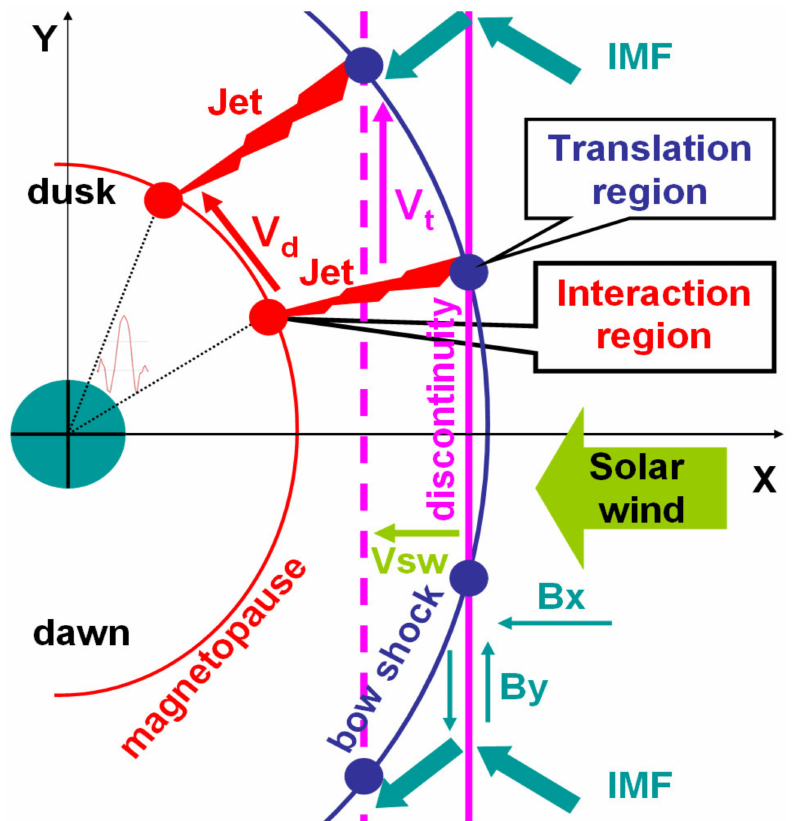
Figure 8. A sketch of the solar wind interaction with the magnetosphere during the generation of traveling jet in the magnetosheath. A discontinuity of the IMF By reversal from negative to positive propagates with the solar wind velocity Vsw from the noon sector (violet solid line) toward flanks (violet dashed line). Interaction of the discontinuity with the bow shock (blue curve) results in formation of a translation region (blue closed circles) where the foreshock translates from prenoon to postnoon sector. The translation region travels with the transversal velocity Vt while the discontinuity is sliding along the bow shock. A fast plasma jet (red lightning) is continuously generated in the translation region, and then it propagates across the magnetosheath streamlines and hits the magnetopause (red curve) in an interaction region (red closed circles). The interaction region, in turn, drifts along the magnetopause with velocity Vd. Disturbances in the high-latitude atmosphere of the Earth (green closed circle) are produced by the interaction